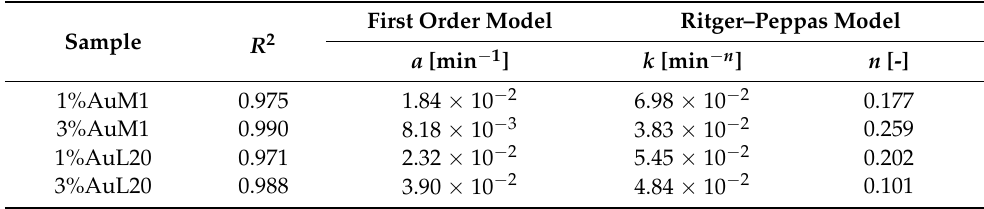
Table 7. Fitting parameters of drug